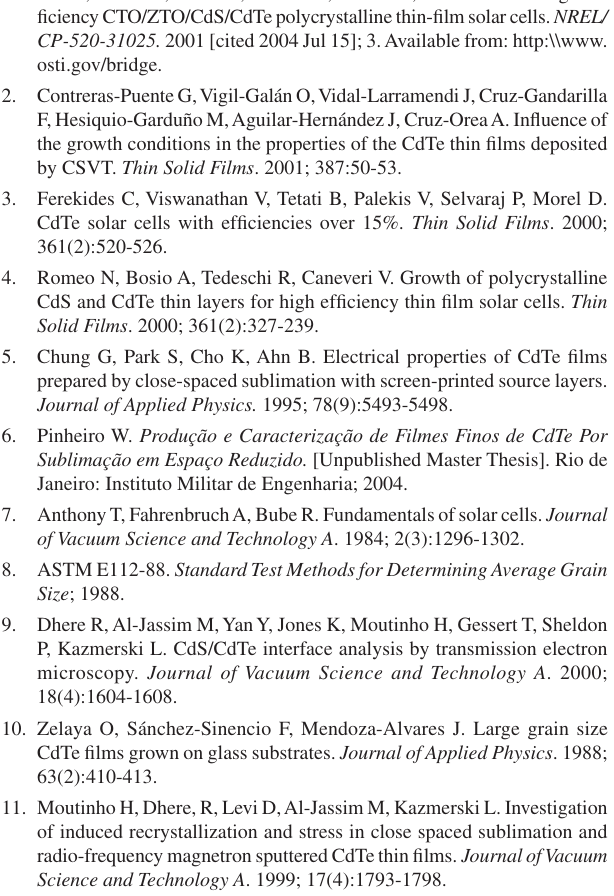
Table 6. Composition of CdTe films deposited at T P = 10 Torr, using different amounts of oxygen in the gaseous atmos- mixt phere. %O 2